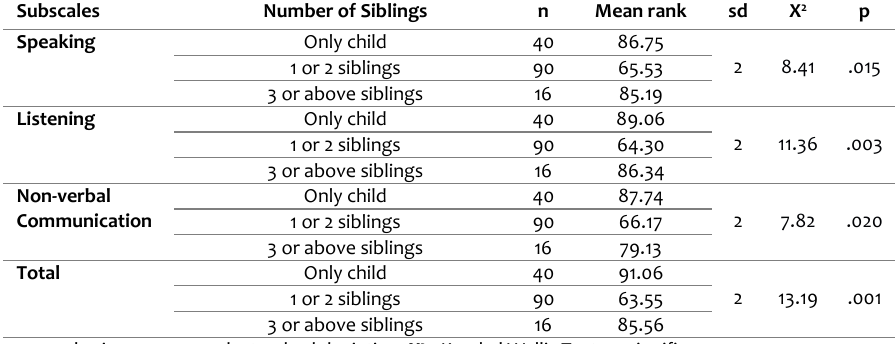
Table 3. The Parent-Child Communication Assessment Tool (PCCAT) Kruskal Wallis Test Results regarding the Subscale Scores for the Number of Children’s Siblings